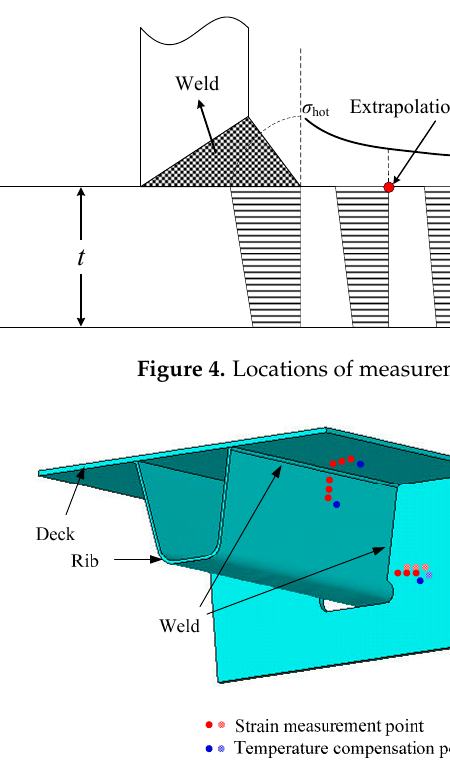
Figure 5. Details of measurement points.